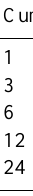
Table 6. Estimated return period (RP) in years for rainfall accumu- lated in the 1, 2, 5, 10, 20, 30, 60, 90, 120 and 180 days prior to 1 October 2009 for Santo Stefano di Briga (SSB) and Messina Istituto Geofisico (MIG) rainfall stations.